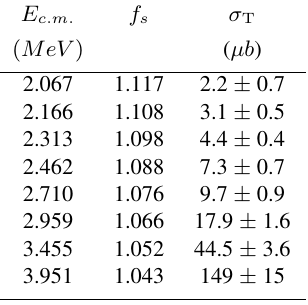
Table 3. Same as in table 2, but for the total cross sections σ T measured for 107 Ag( p, γ ) 108 Cd. E c.m. f